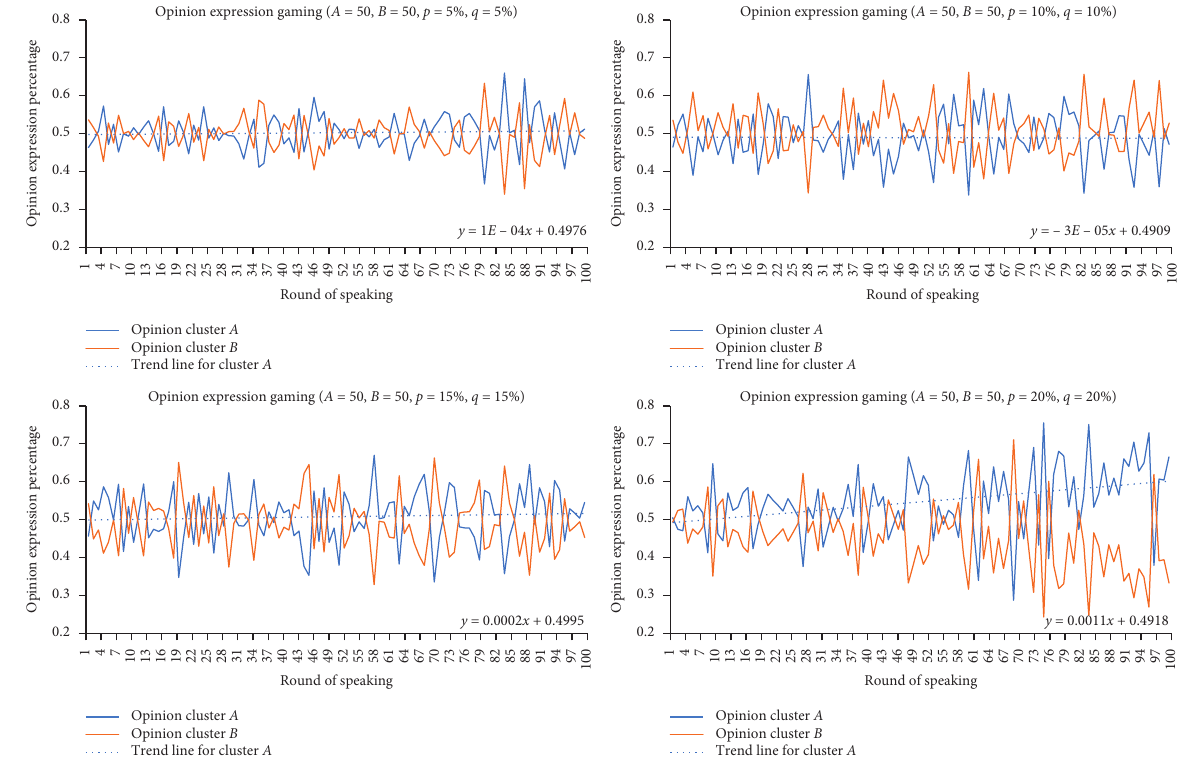
Figure 3: Balanced opinion situation ( A � 50 and B � 50). Note. Opinion expression percentage, with A (minority cluster) � blue thick line and B (majority cluster) � red thin line. Round of speaking represents time because each discussion allows 100 rounds of speaking. All the results were shown in the average score of 100 times’